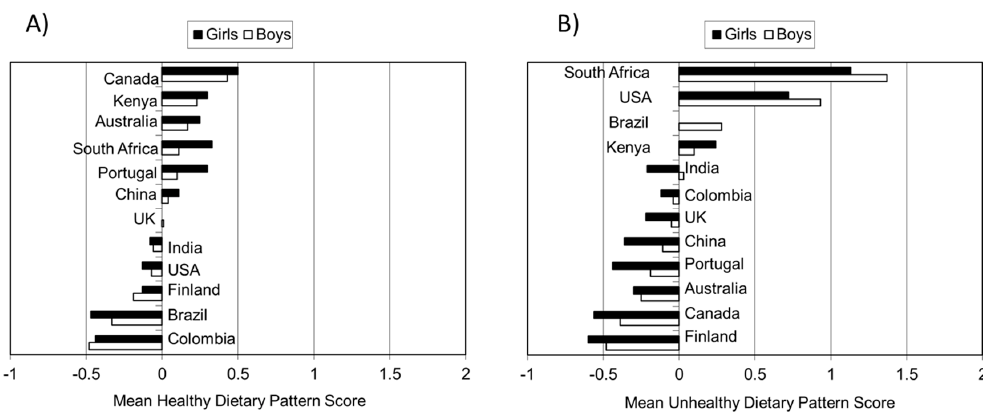
Figure 3. Mean dietary pattern scores across ISCOLE study sites. ( A ) presents the mean scores for the “healthy dietary pattern” and ( B ) presents the mean scores for the “unhealthy dietary pattern”. Data were obtained from Mikkila et al. [25].